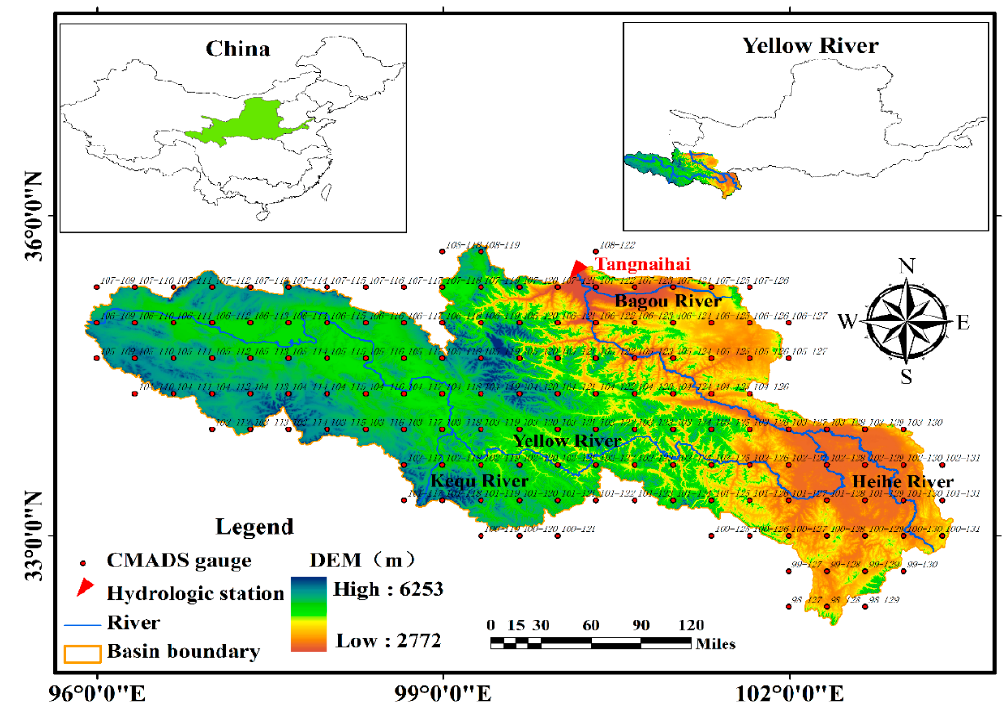
Figure 1. Locations of the Yellow River source region.